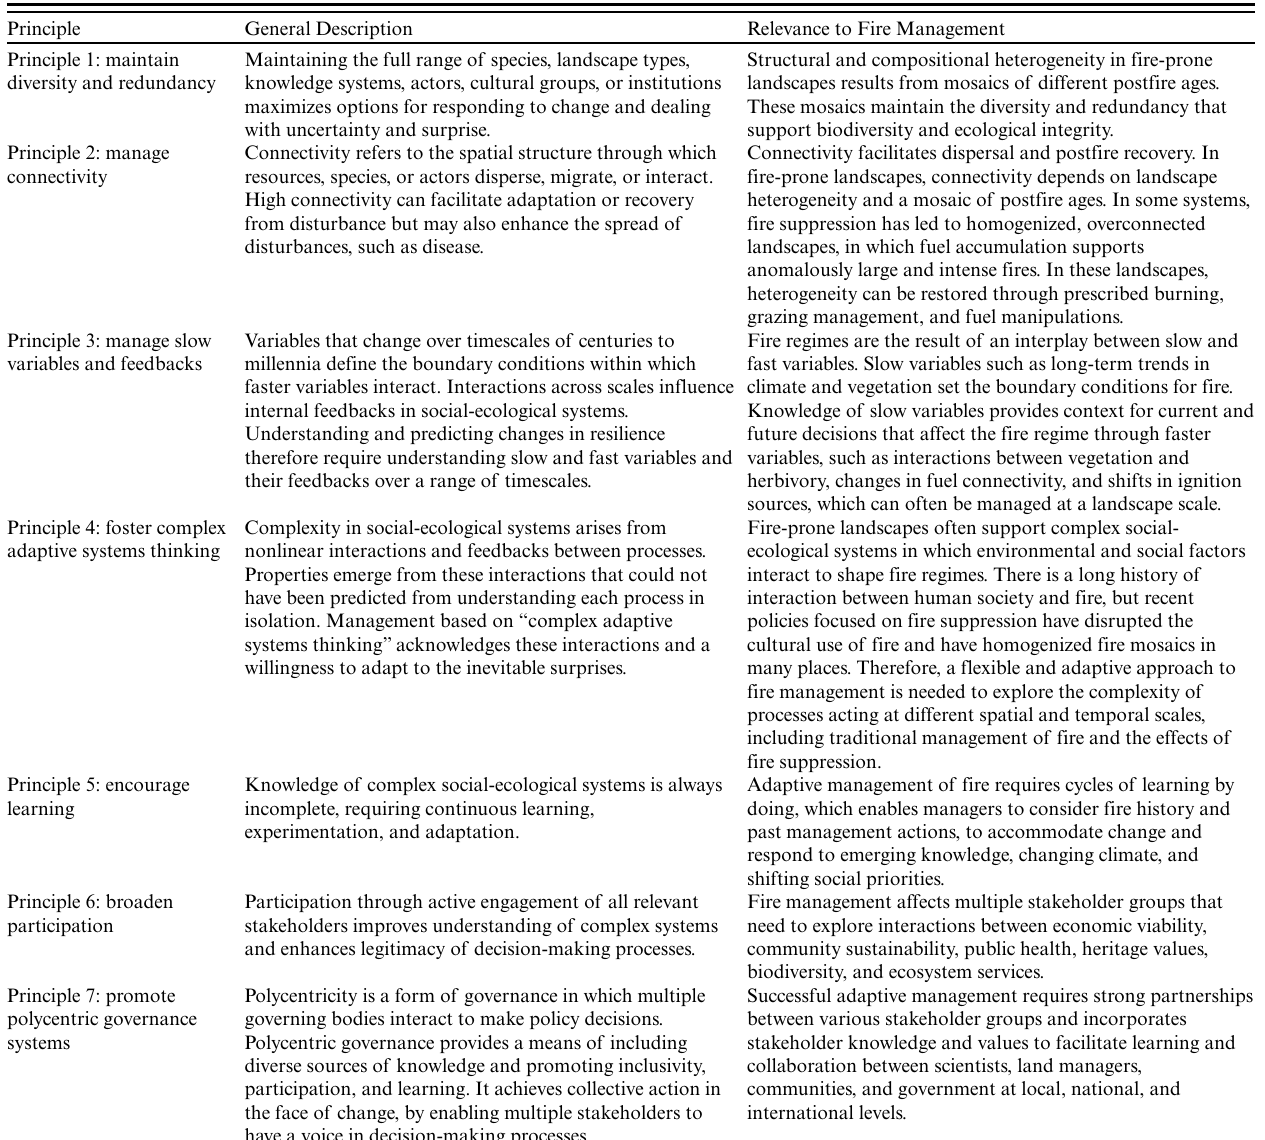
Table 1 . Seven principles for building resilience (modified from Biggs et al.